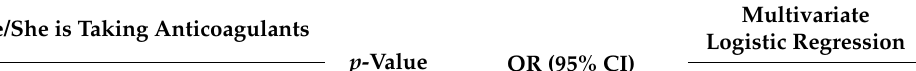
Table 8. Sociodemographic, clinical and mental characteristics in groups that differ in anticoagulant drug intake and test